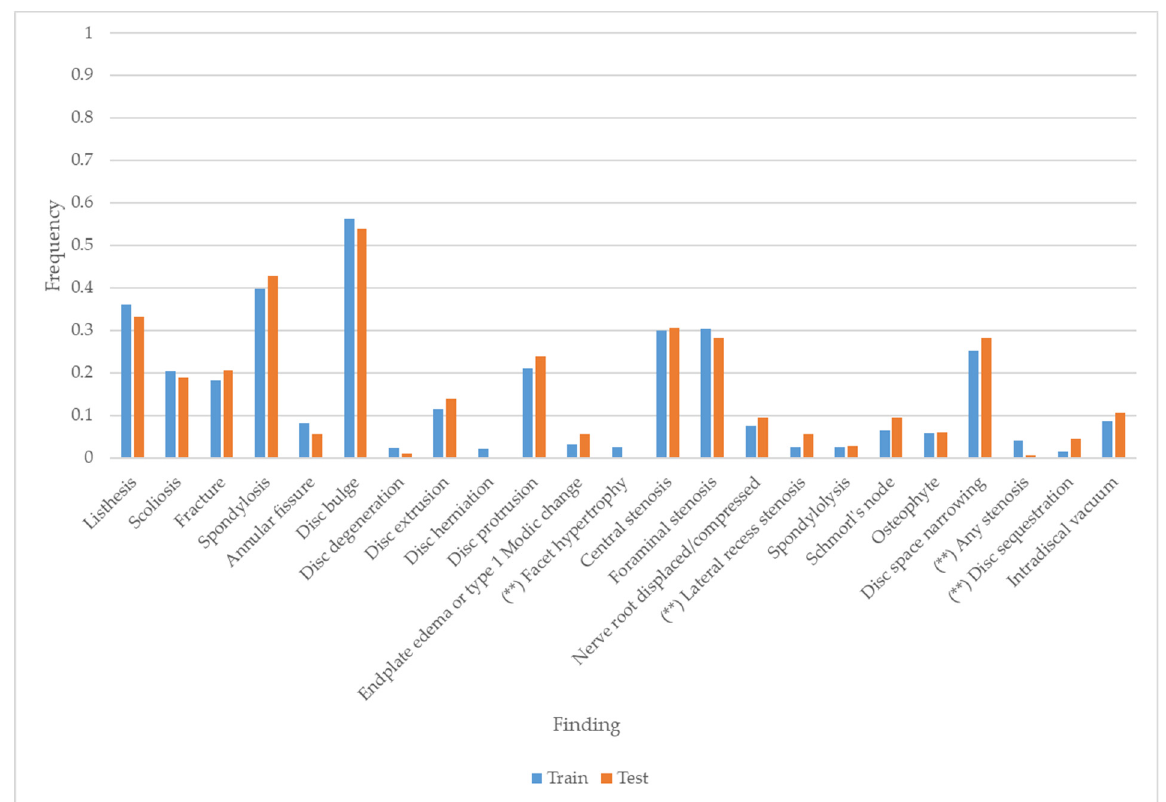
Figure 2. Frequency of the radiologic findings between the training and test datasets. (**) indicates a statistically significant difference ( p ‐ value < 0.05).